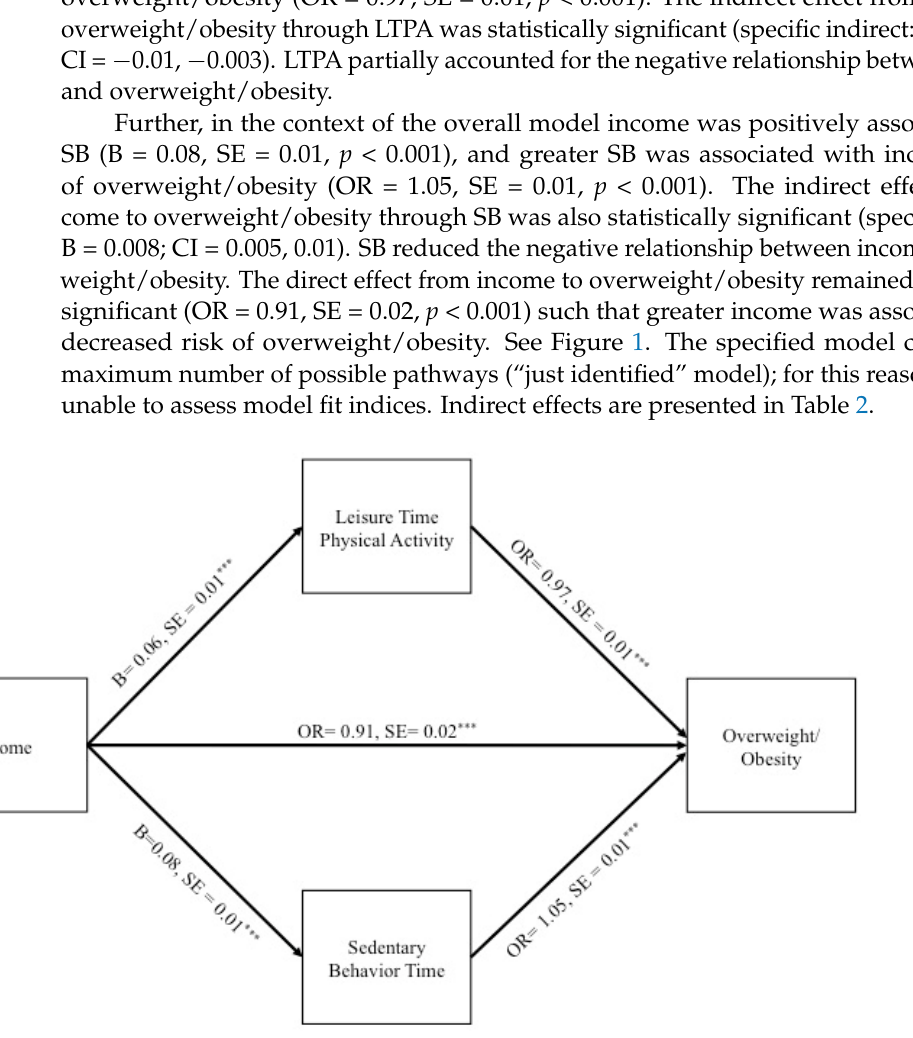
Figure 1. Multiple Mediator Structural Equation Model Assessing the Role of Leisure Time Physical Activity and Time in Sedentary Behaviors on the Income-Overweight/Obesity Relationship. Total effect: B = − 0.043; CI = − 0.07, − 0.02; *** p < 0.001; NOTE: The specified model contains the maximum number of possible pathways (“just identified” model); for this reason, we were unable to assess model fit indices. Each pathway includes the following covariates (not pictured): age, sex, race/ethnicity, nativity status, marital status, education, employment status, health insurance, Healthy Eating Index, alcoholic beverage consumption, and smoking status. The residual errors of leisure time physical activity and sedentary behavior time were correlated (not